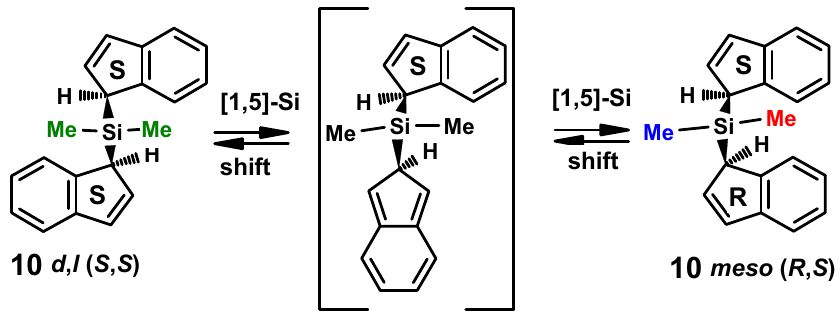
Scheme 5. Interconversion of d,l and meso diastereomers of bis(indenyl)dimethylsilane, 10 . We focus here briefly on tris(indenyl)methylsilane, 11 , which gives rise to RRR , RRS , RSS and SSS isomers in a 1:3:3:1 ratio, where the R and S labels refer to the absolute con- figuration of C(1) in each indenyl ring, as shown in Scheme 6.